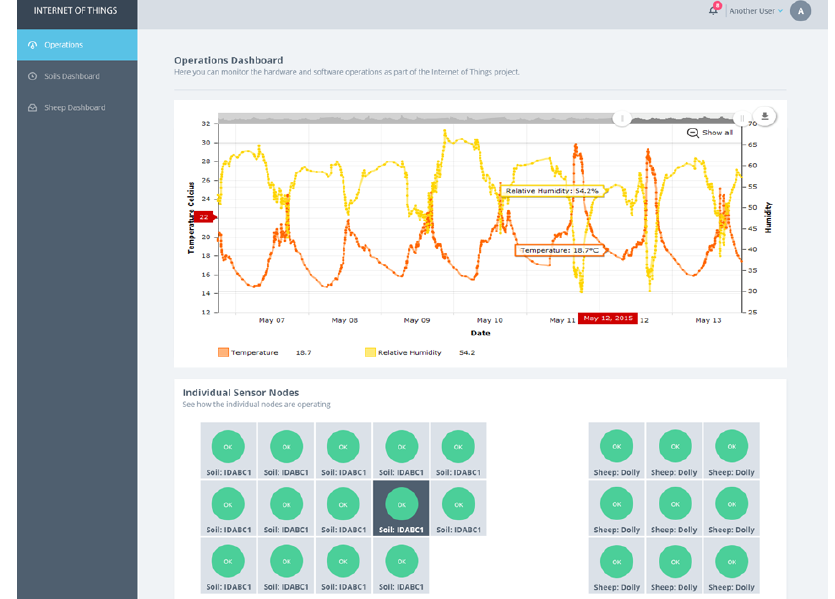
Figure 11. Readings for one soil